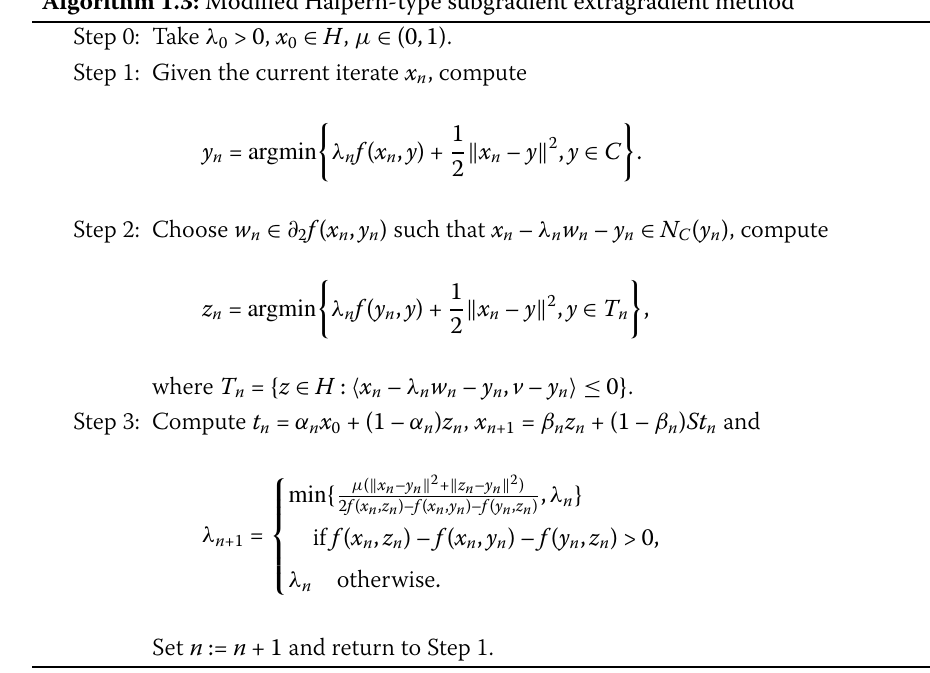
Algorithm 1.3: Modified Halpern-type subgradient extragradient